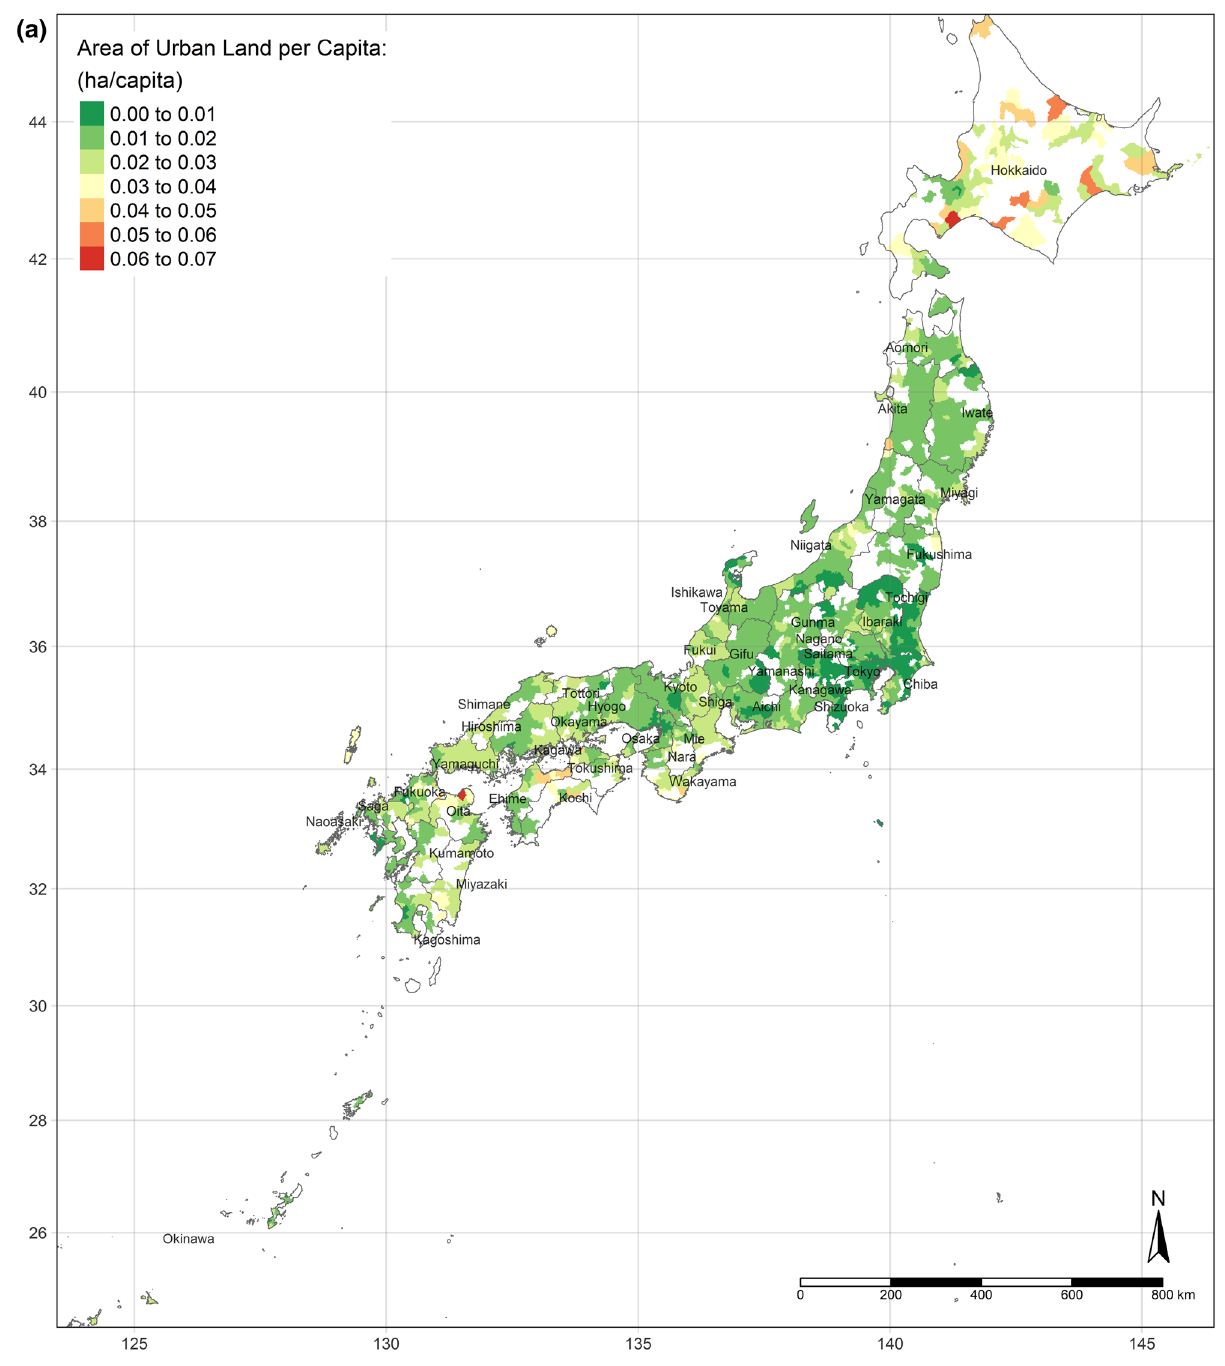
Figure 2. ( a ) Area of urban land per capita. ( b ) Area of water per capita. ( c ) Area of bare land per capita. (Figure a, b, c is created by R 4.0.4, https:// cran.r- proje ct. org/ bin/ windo ws/ base/ old/4.